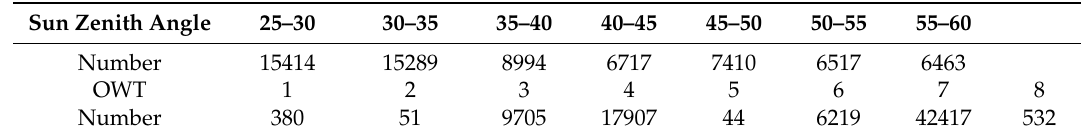
Table 4. Number of spectra versus sun zenith angle and